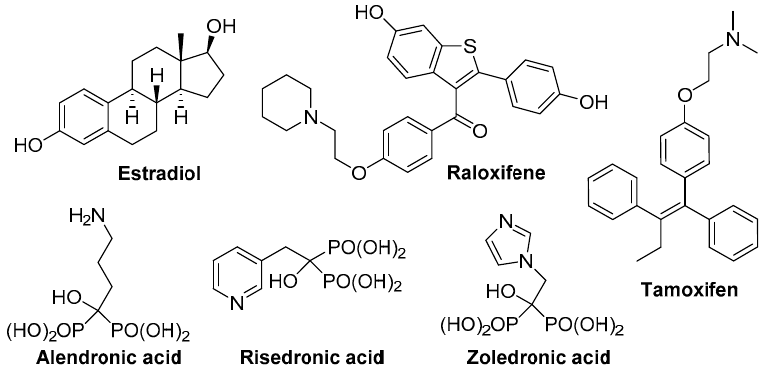
Figure 1. Representative anti-osteoclastic drugs.